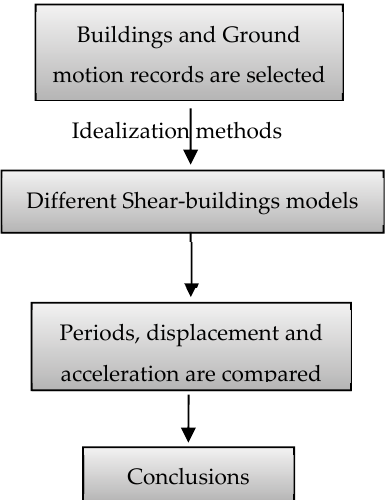
Figure 3. Flowchart of this paper.